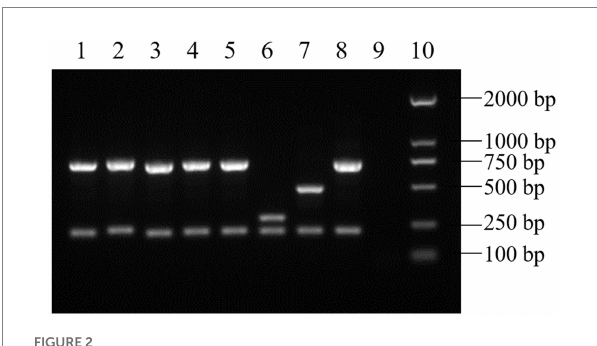
FIGURE 2 AMOS-PCR results of the Brucella isolates (partial). (1–5) Brucella isolates. (6) B. suis S2. (7) B. abortus A19. (8) B. melitensis 16 M. (9) Negative control. (10) DL2000 DNA